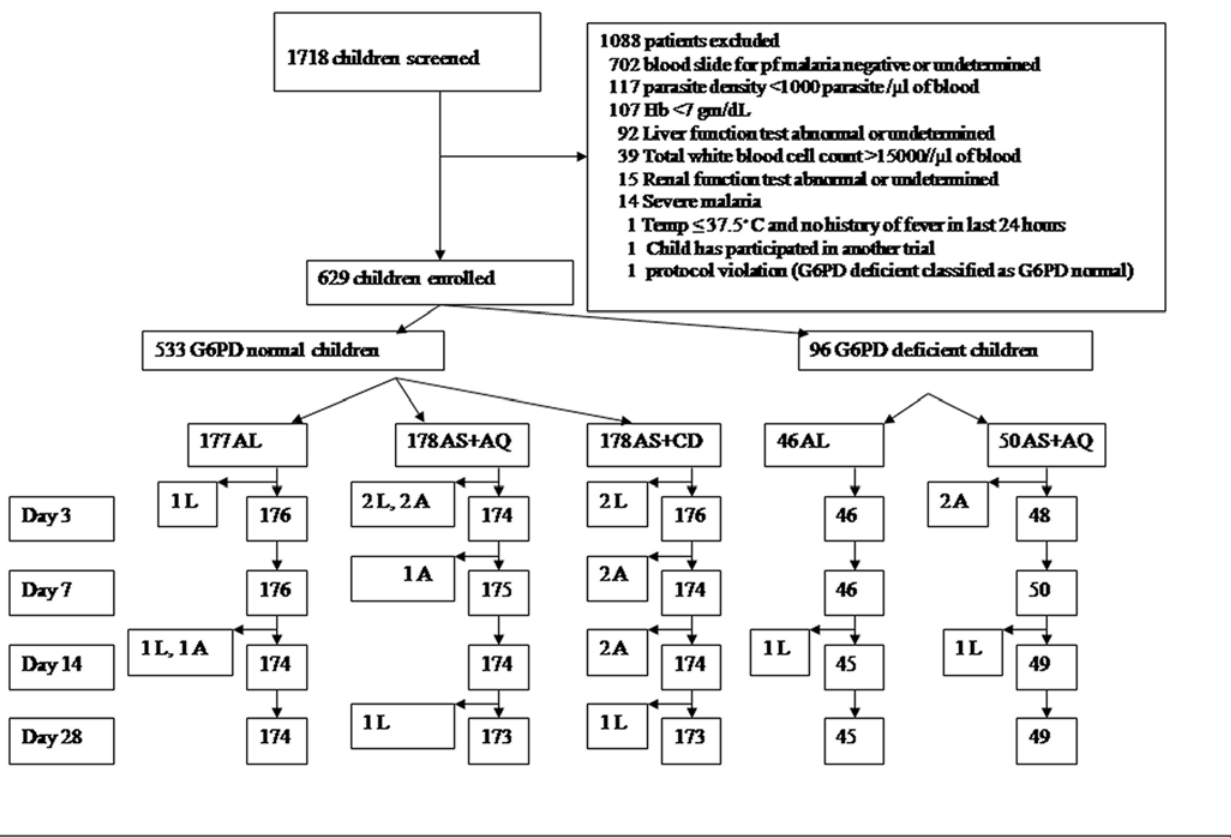
Figure 1. Enrolment and Follow up profile.